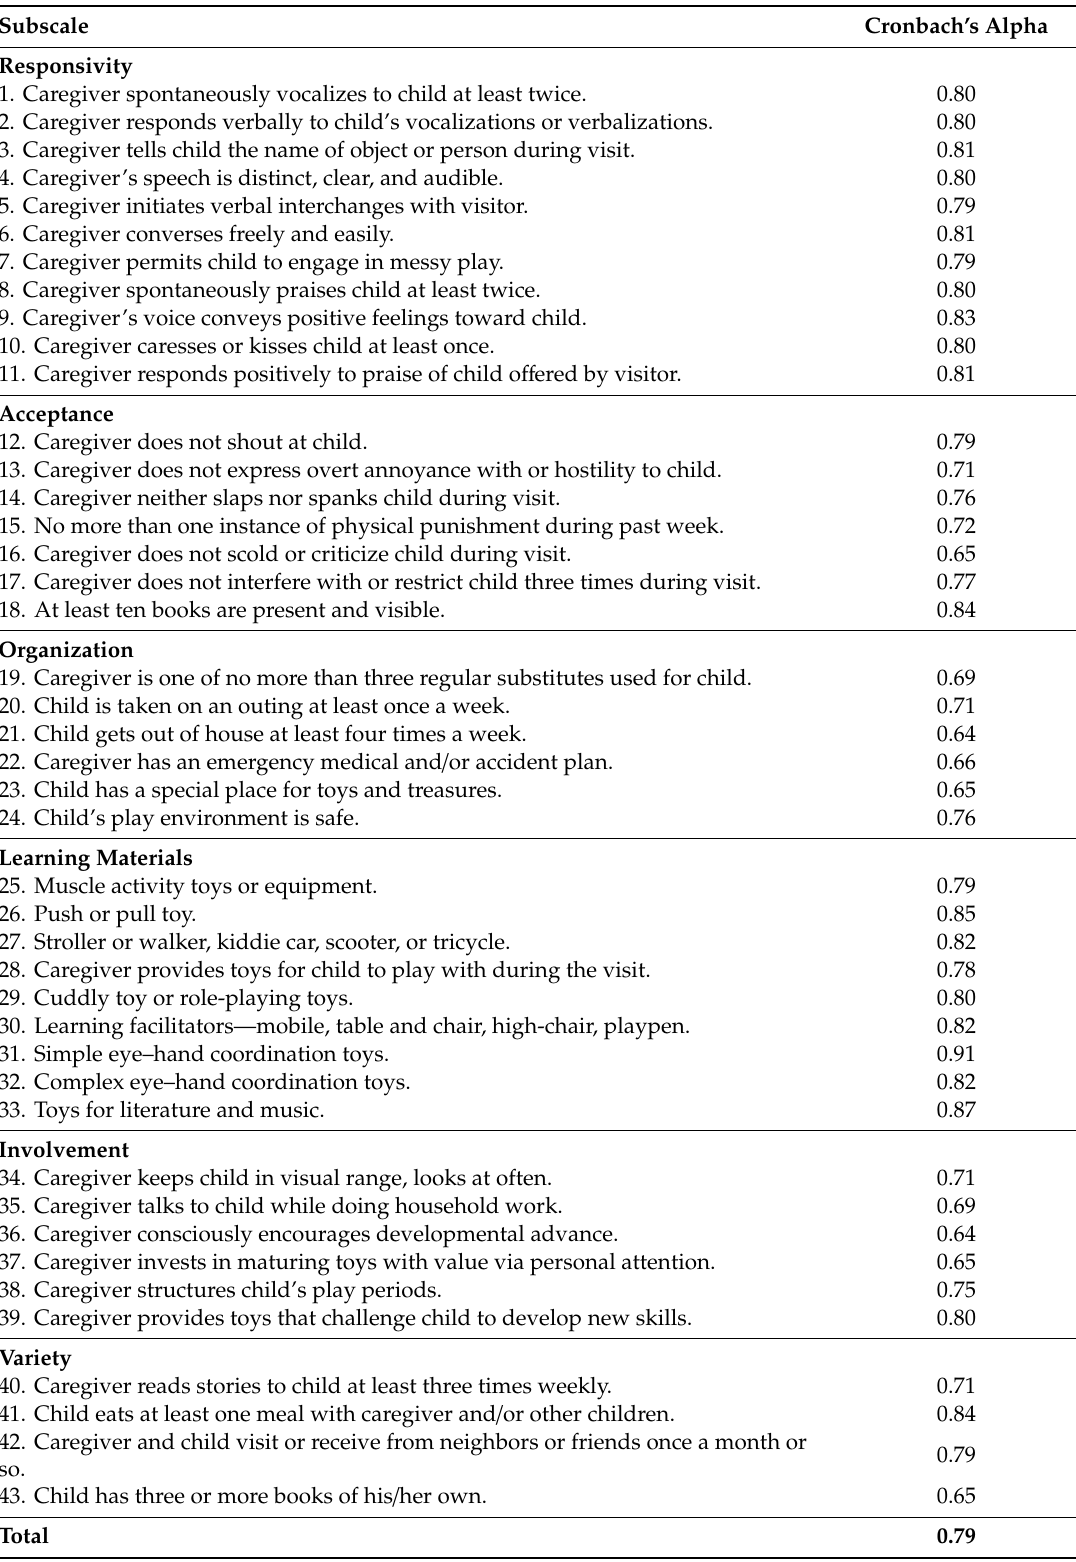
Table A1. The Home Observation for Measurement of the Environment inventory (infant